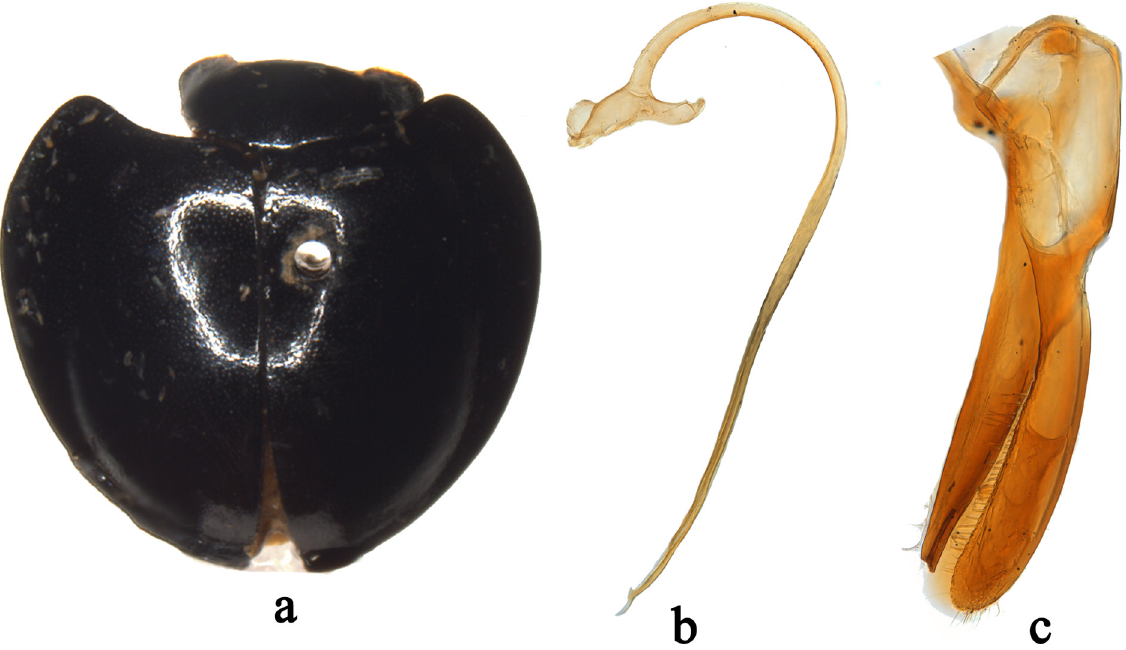
Fig. 2. Chilocorus yunlongensis Cao & Xiao, 1984. a . Dorsal view. b . Penis. c . Tegmen, lateral view. Scale bars: 0.1 mm.